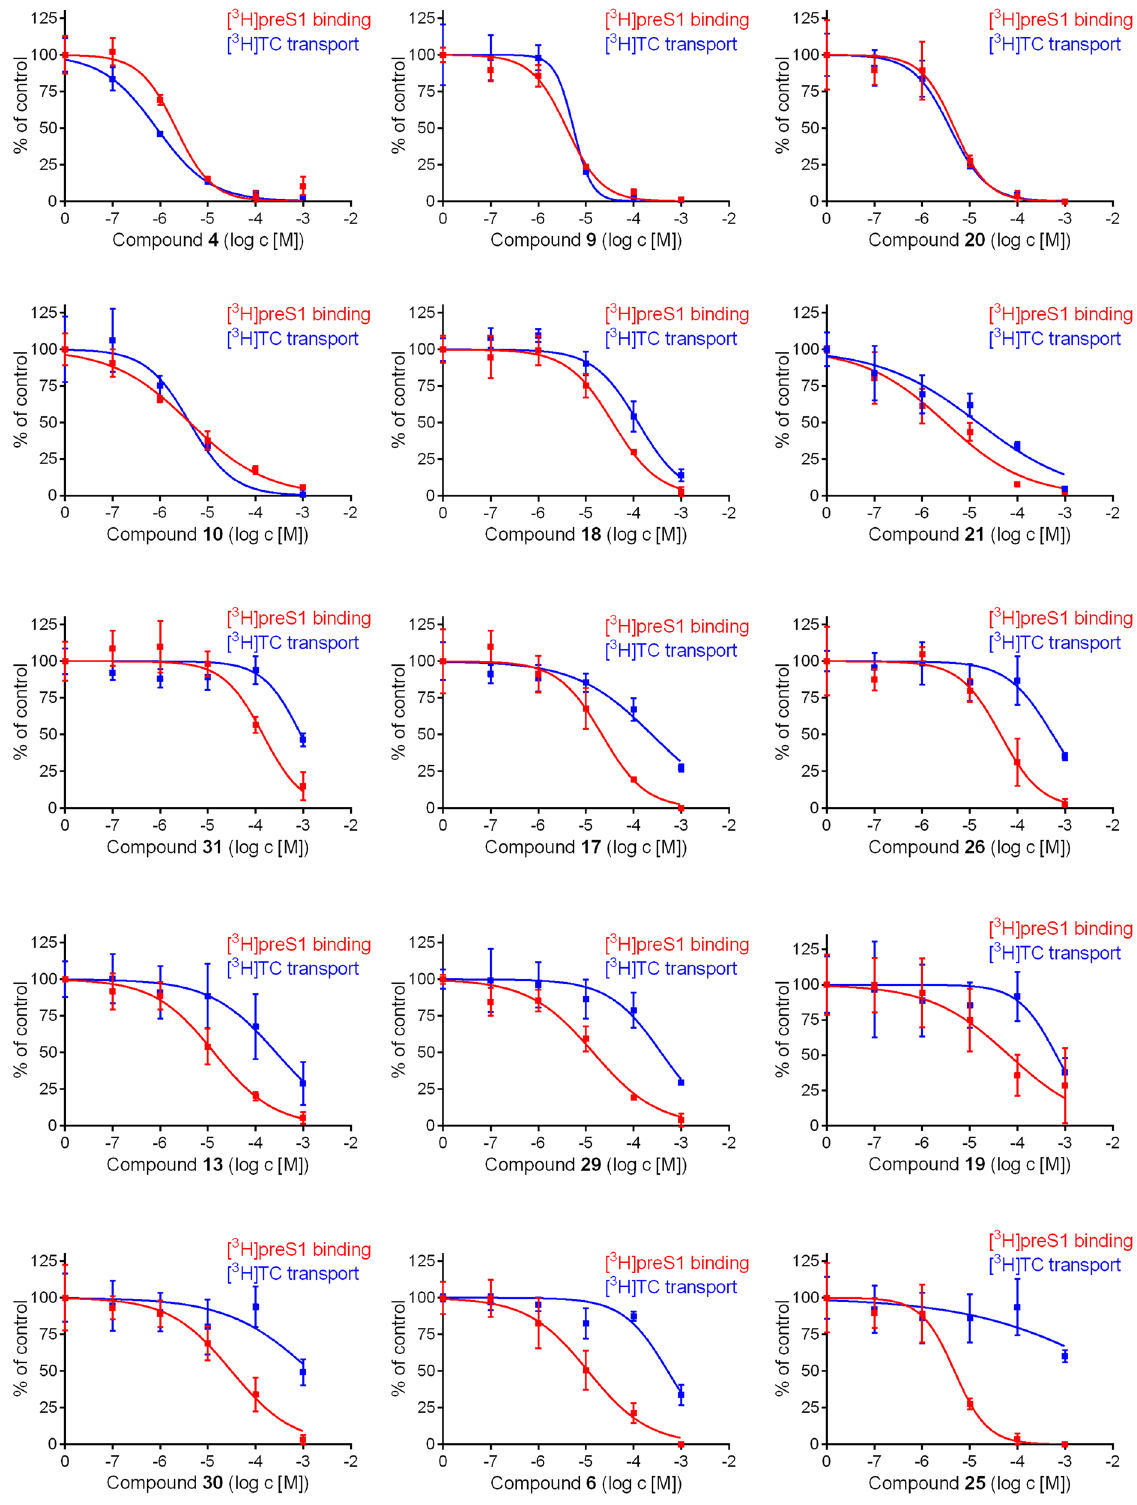
Figure 2. Inhibition of [ 3 H]preS1 peptide binding and [ 3 H]TC transport by betulin derivatives. NTCP-HEK293 cells were incubated with tetracycline in order to induce NTCP expression and were used for bile acid transport experiments with 1 µM [ 3 H]TC and for myr-preS1 2-48 lipopeptide binding experiments with 5 nM [ 3 H]preS1, each over 10 min at 37 °C. Cells without tetracycline treatment were used as 0% controls of [ 3 H]TC uptake and [ 3 H]preS1 binding, respectively. Experiments were performed with solvent alone (set to 100%) and with increasing concentrations of the indicated inhibitor. The mean of the 0% control was subtracted to calculate net [ 3 H]TC transport rates (shown in blue) as well as net [ 3 H]preS1 binding rates (shown in red), both expressed as % of control at the y-axis. Half maximal inhibitory concentrations (IC 50 ) were calculated by nonlinear regression analysis using the equation log(inhibitor) vs. response (GraphPad Prism). The figure shows selected diagrams. Chemical structures of the compounds are depicted in Table 1, the respective IC 50 values are listed in Table 2. Data represent means ± SD of quadruplicate determinations (n =